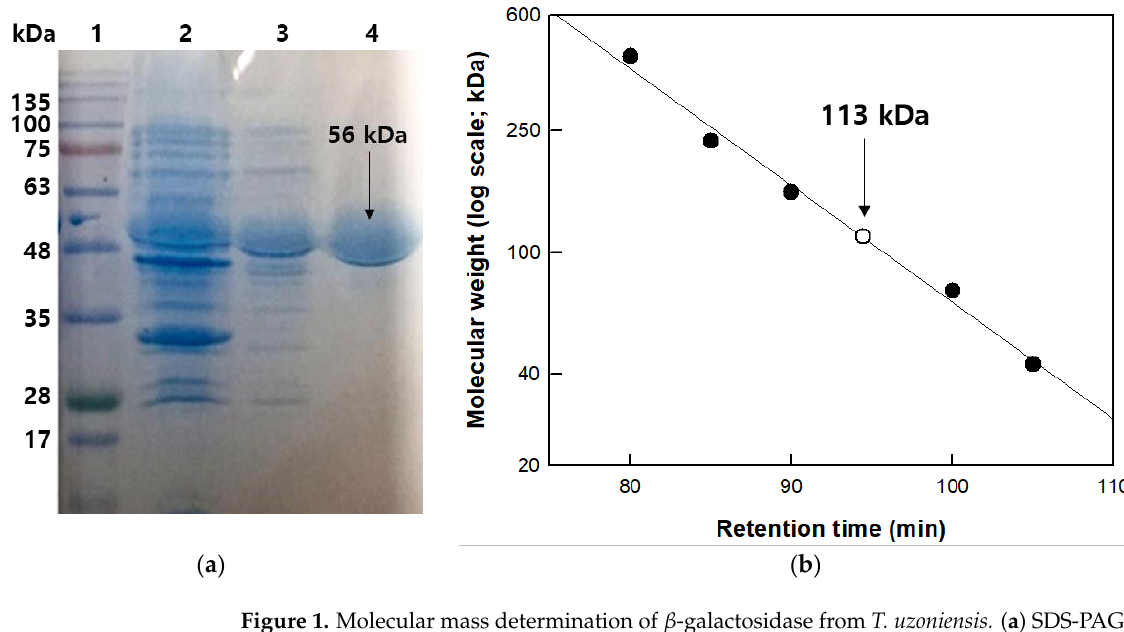
Figure 1. Molecular mass determination of β -galactosidase from T. uzoniensis. ( a ) SDS-PAGE analysis. Lane 1, molecular weight size marker; lane 2, cell debris; lane 3, crude extract; and lane 4, purified enzyme. ( b ) Determination of native molecular mass using gel-filtration chromatography. The reference proteins ferritin (440 kDa), catalase (232 kDa), aldolase (158 kDa), conalbumin (75 kDa), and ovalbumin (43 kDa), and purified β -galactosidase from T. uzoniensis are represented by filled circles and open circles,